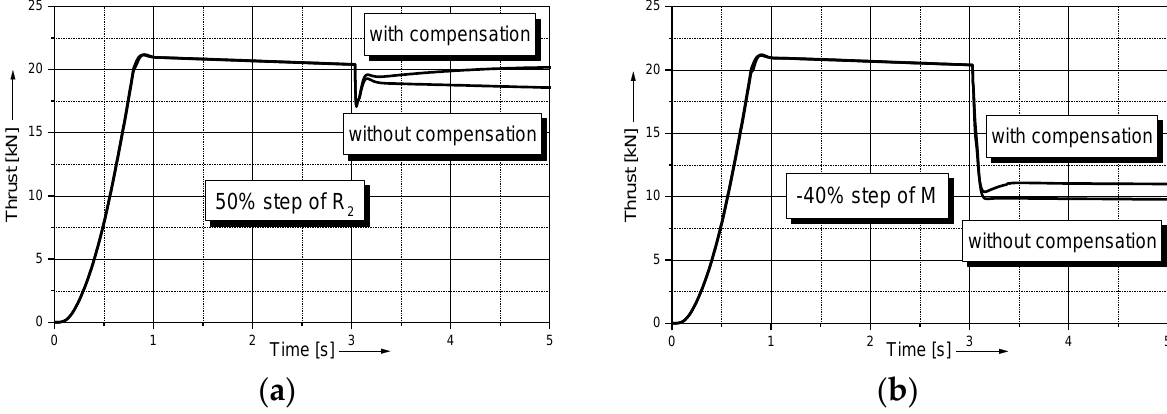
Figure 10. Response to a step of the secondary resistance R 2 ( a ); response to a step of the mutual inductance M ( b ) [29].